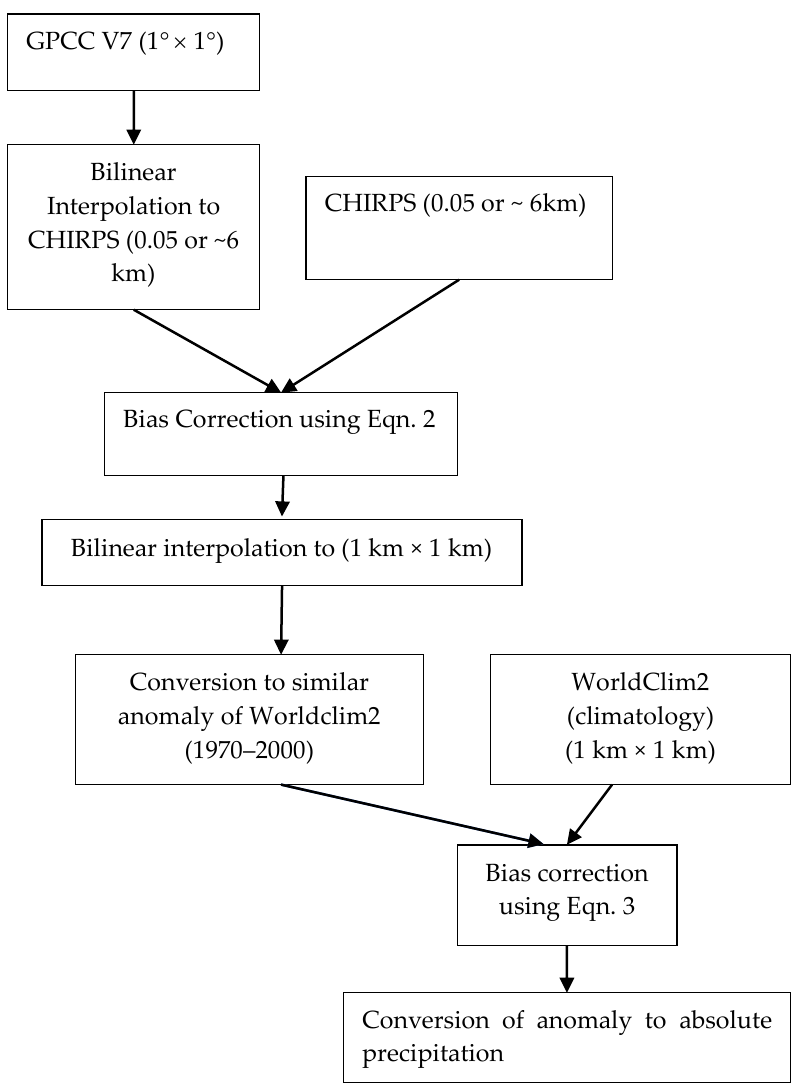
Figure 3. Flowchart showing downscaling procedure of precipitation.